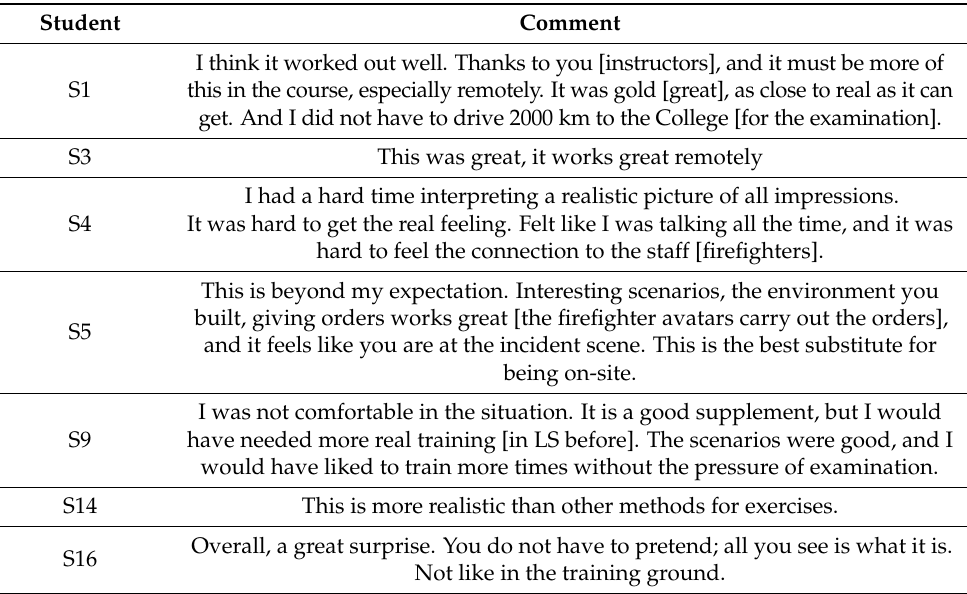
Table 3. Students’ experience of the RVS examination, oral comments (documented in notes and video recordings), and/or written free text comments on post-exam